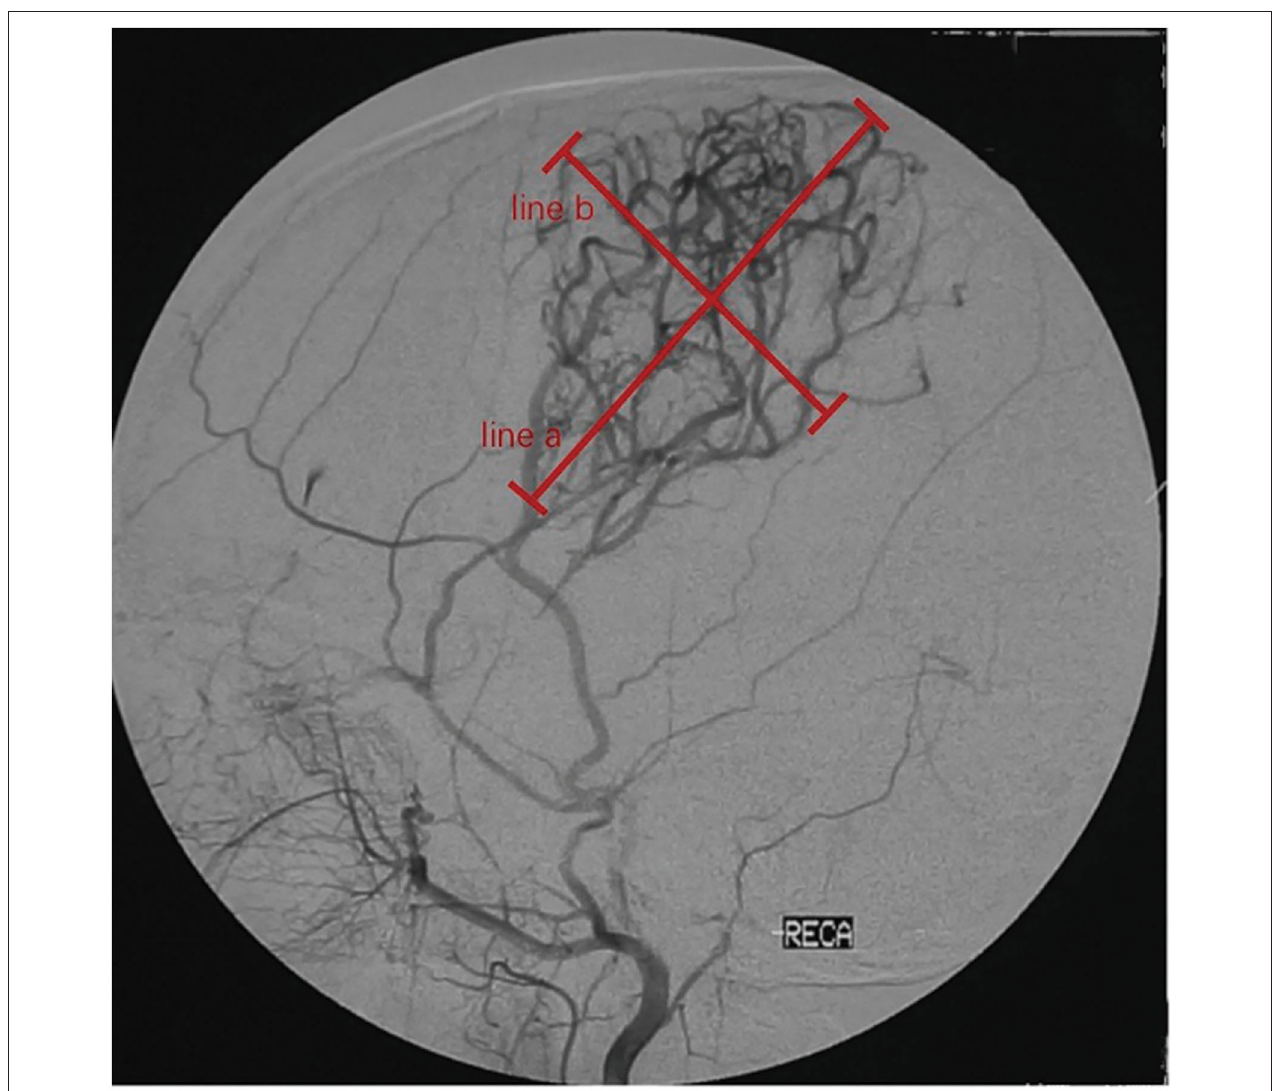
FIGURE 1 | Quantitative measurements on follow-up digital subtraction angiography (DSA). Measurements were taken on the lateral view. Width (line a) was measured as the longest horizontal distance of the area covered by neoangiogenesis. Height (line b) was measured as the longest vertical distance of the area covered by